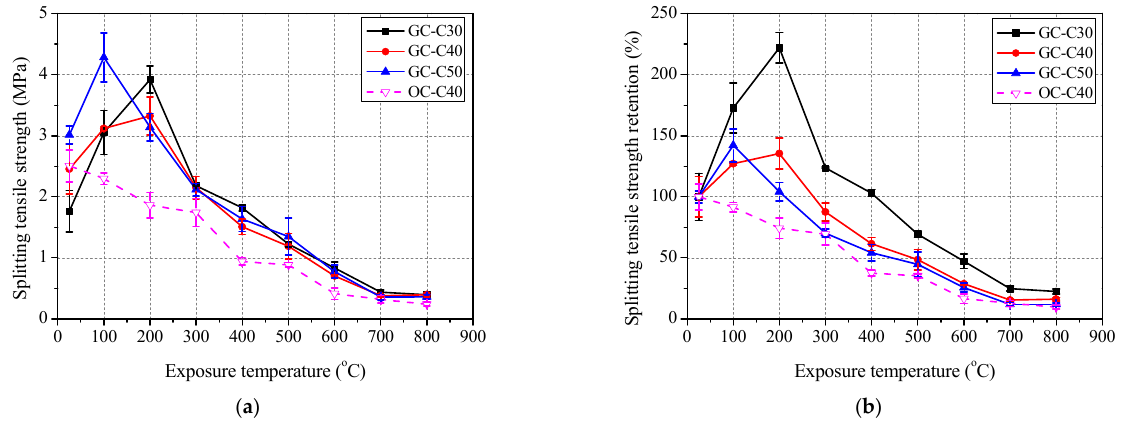
Figure 8. Residual splitting tensile strength of concrete after exposure to elevated temperature: ( a ) splitting tensile strength and ( b ) retention.